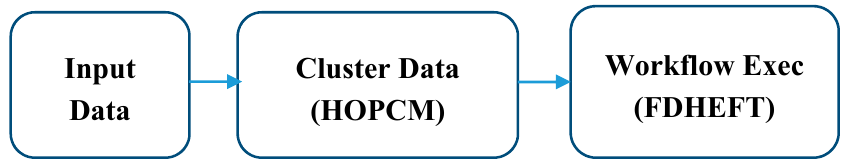
Figure 2. Cloud intelligent system scheduling processes.